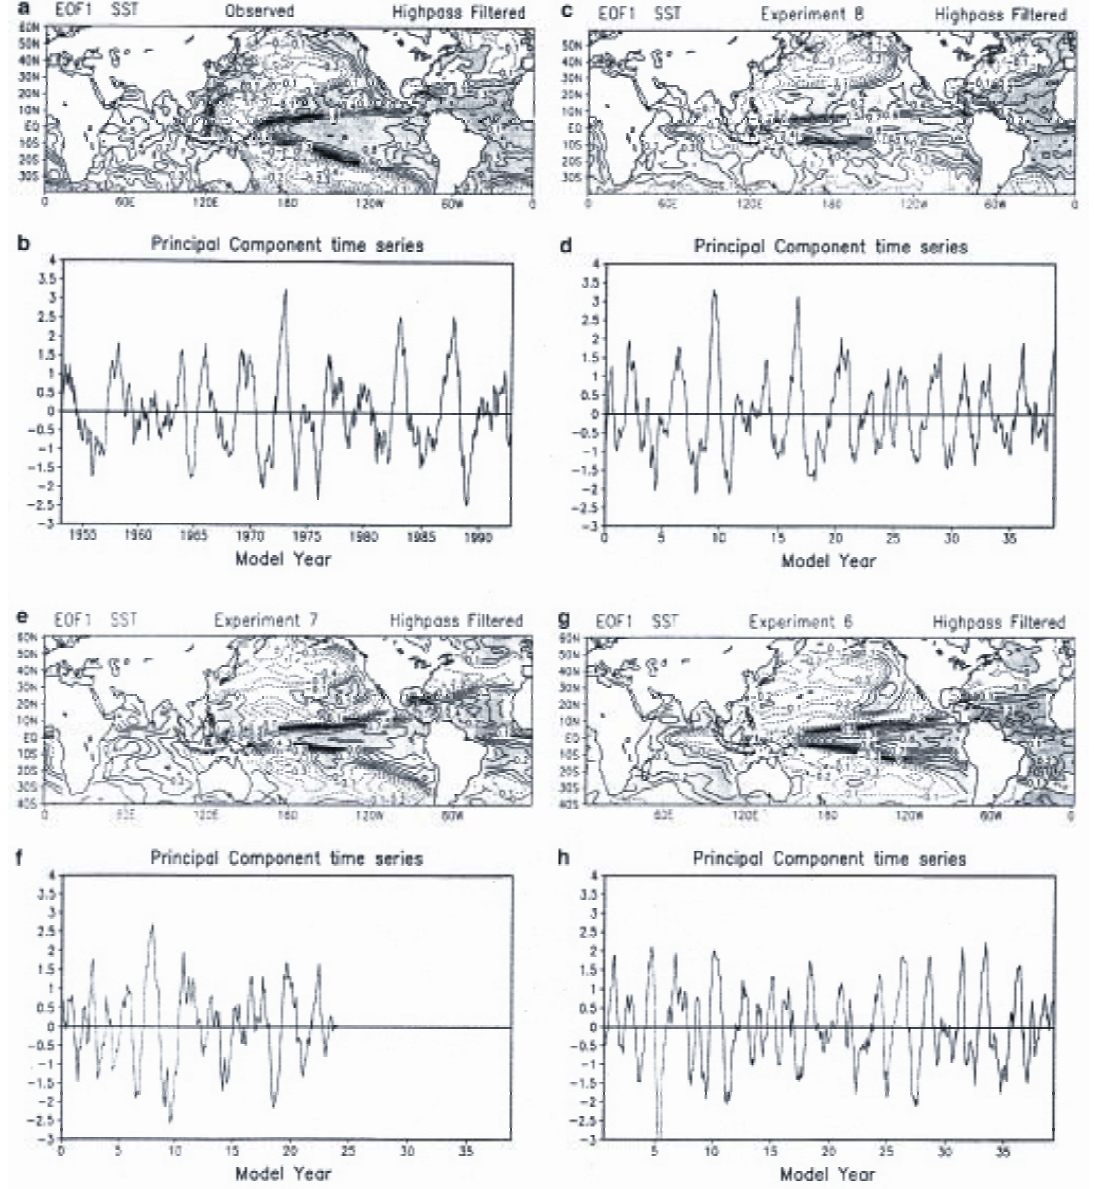
FIGURE 17. Comparison of observed El Niño ((a) and (b) from Reynolds and Smith [132] with modeled ((c) and (d) from Washington et al.[101]). a and c are EOF1 from high pass filtered monthly SST, b and d are normalized principal component time series corresponding to EOF1. (From Meehl et al. (2001) Factors that affect the amplitude of El Niño in global coupled climate models, Clim. Dynamics , 17, 515–526. With